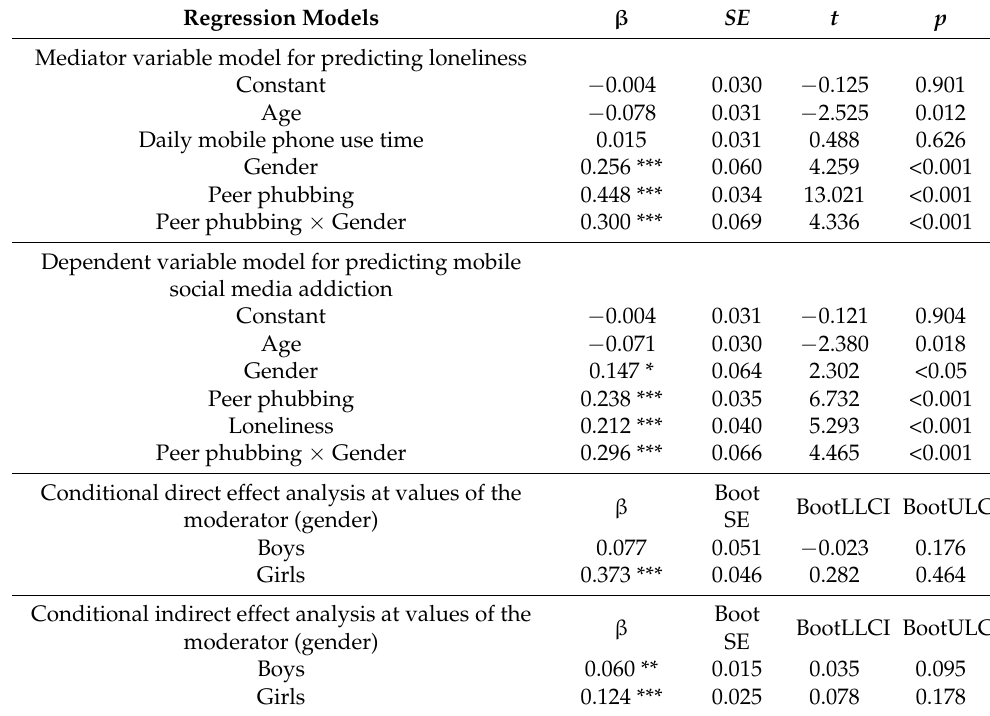
Table 4. Moderated mediation analysis.